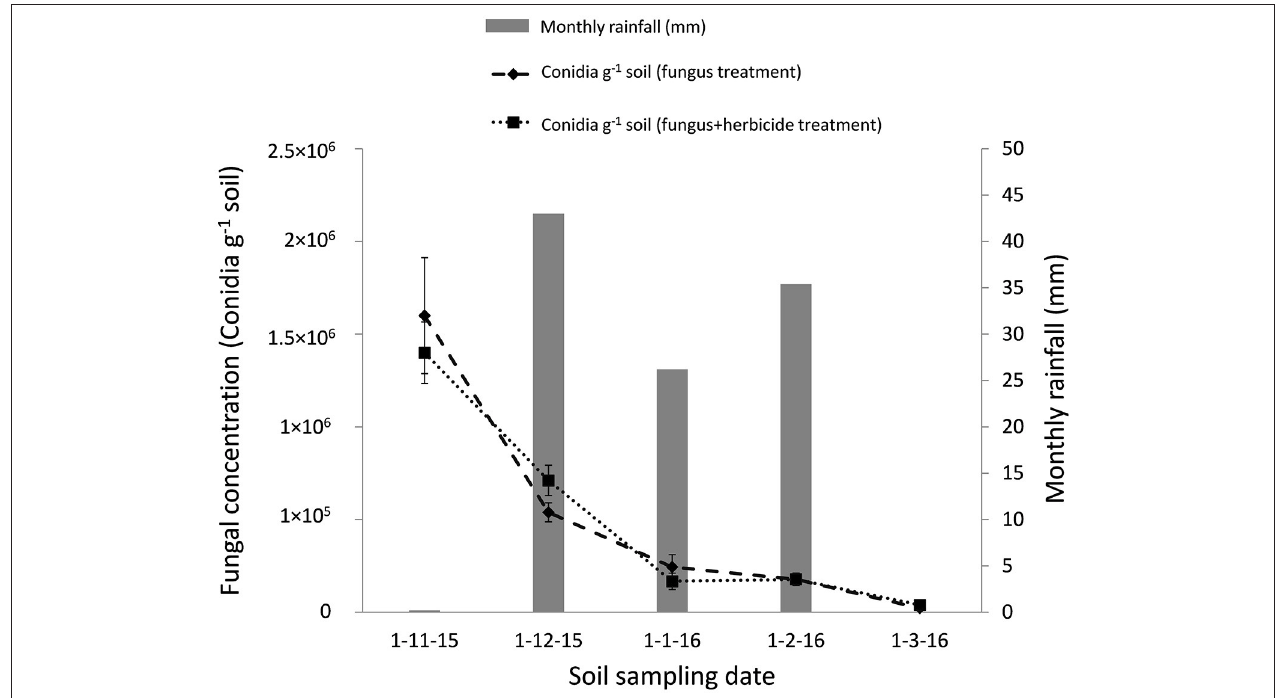
FIGURE 3 | Time course of M. brunneum concentration in the soil (Southern Spain) after both fungus treatment and fungus-herbicide simultaneous treatment and monthly rainfall during the